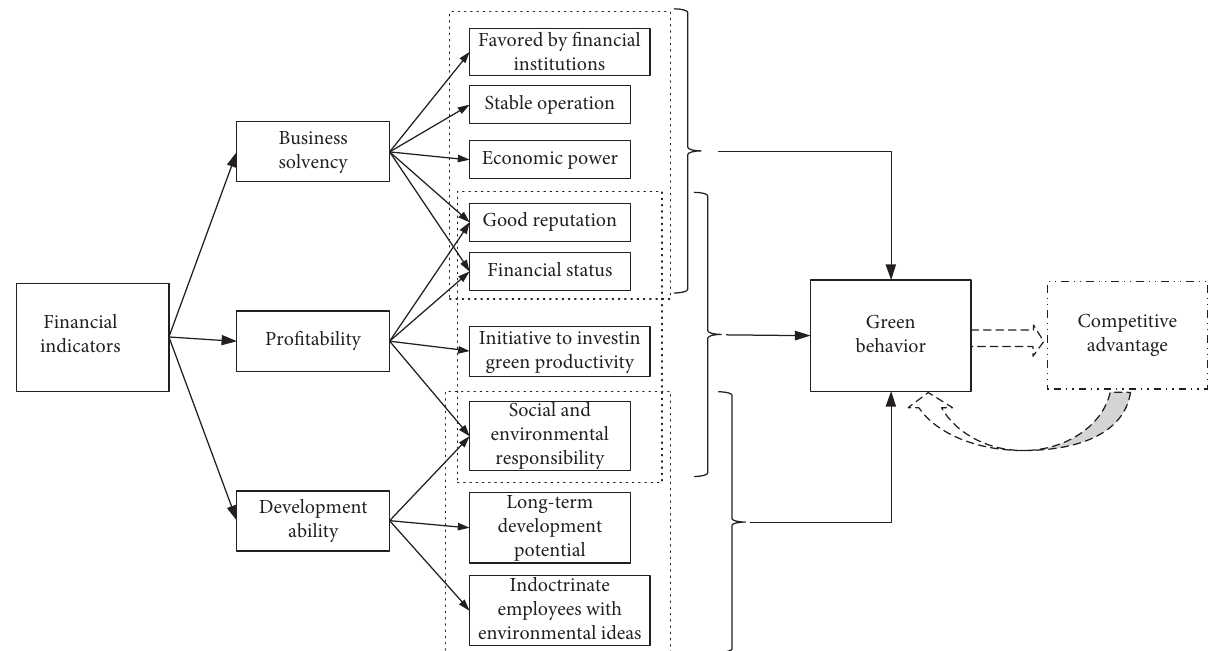
Figure 4: The relationship mechanism between variables.